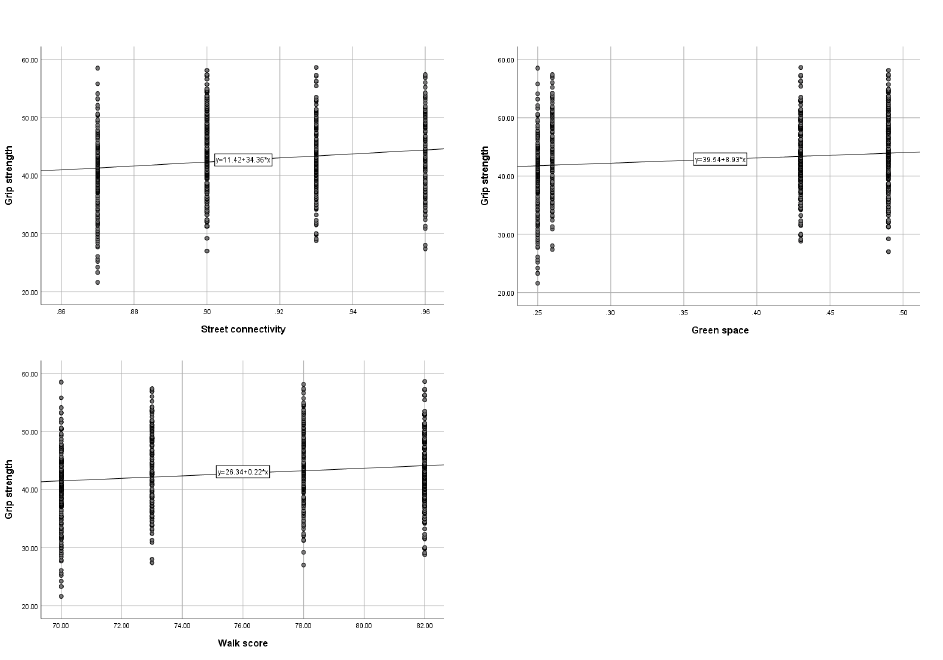
Figure A1. The specimen scatterplots for correlation between grip strength and built environment in male students.